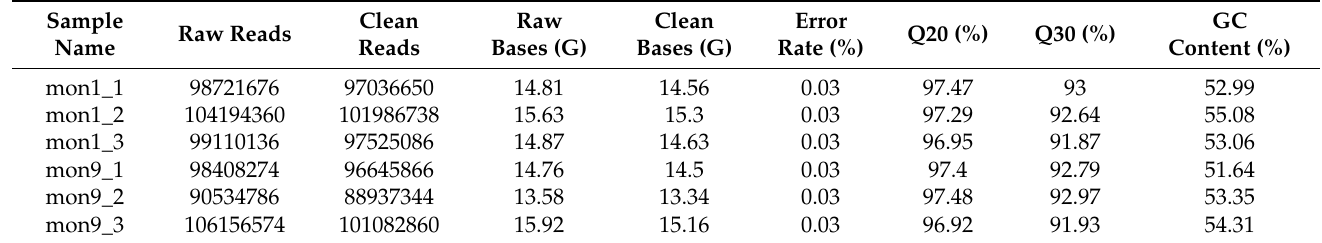
Table 2. Data summary of RNA-seq in goat muscle.